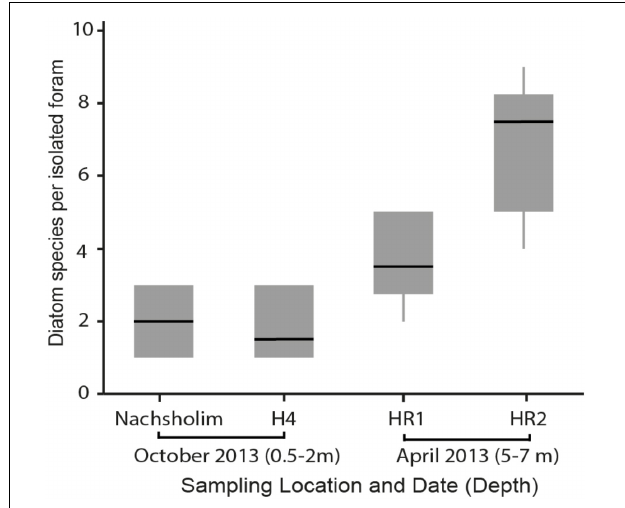
FIGURE 5 | Diatom diversity found in isolations of the benthic foraminifera P. calcariformata performed for this study ( N = 40), specimens were obtained from the locations affected by the heat plume (H4, HR1, HR2) and the control station (Nachsholim) at respective sampling dates and